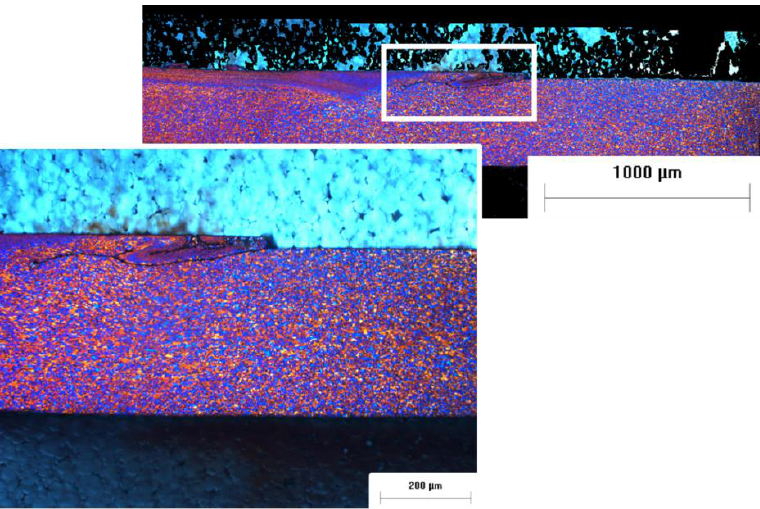
Figure 3. Panoramic POM of sample 4 after the 10% overall reduction. The onset shows a magnifi- cation of the welded joint with a large crack.